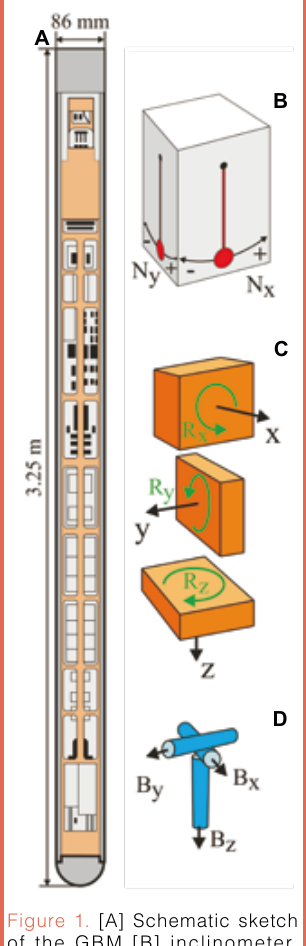
Figure 1. [A] Schematic sketch of the GBM [B] inclinometer, [C] fiber-optic gyros, [D] Förster- magnetometer